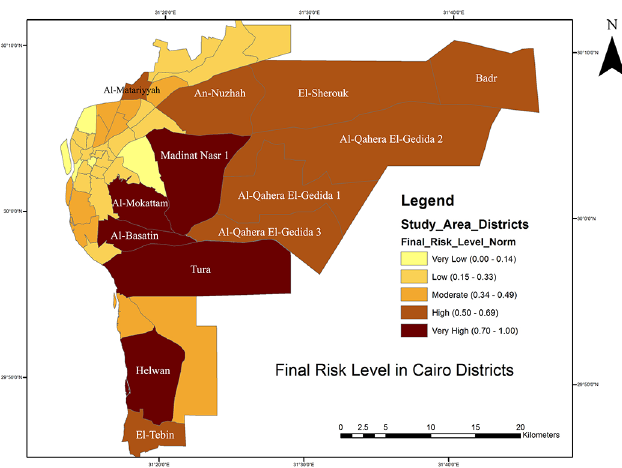
Fig. 10. Final risk layer in Cairo Governorate districts. Source: (Author).